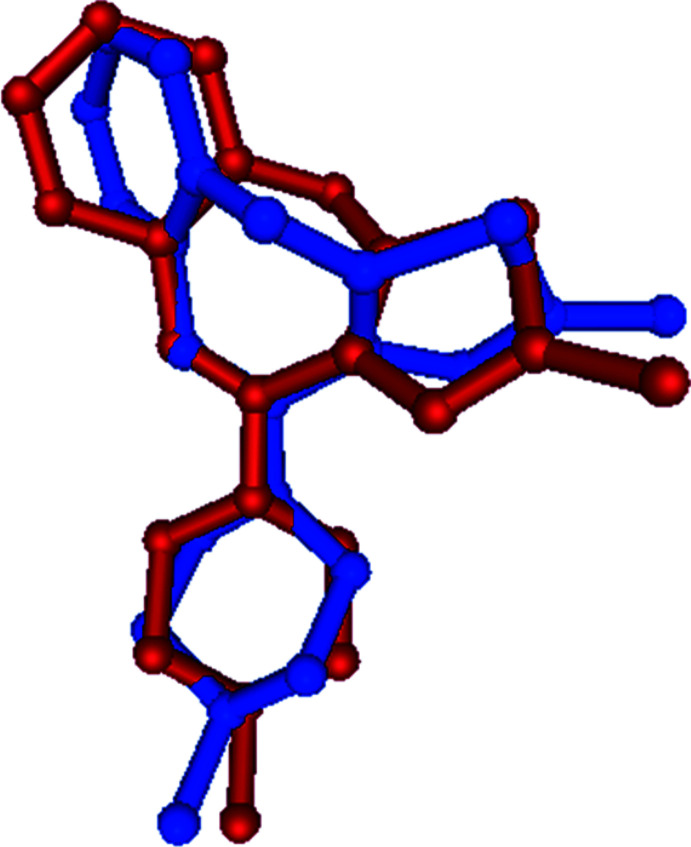
A superimposed fit of (I) (red) and the related structure (II) (blue).